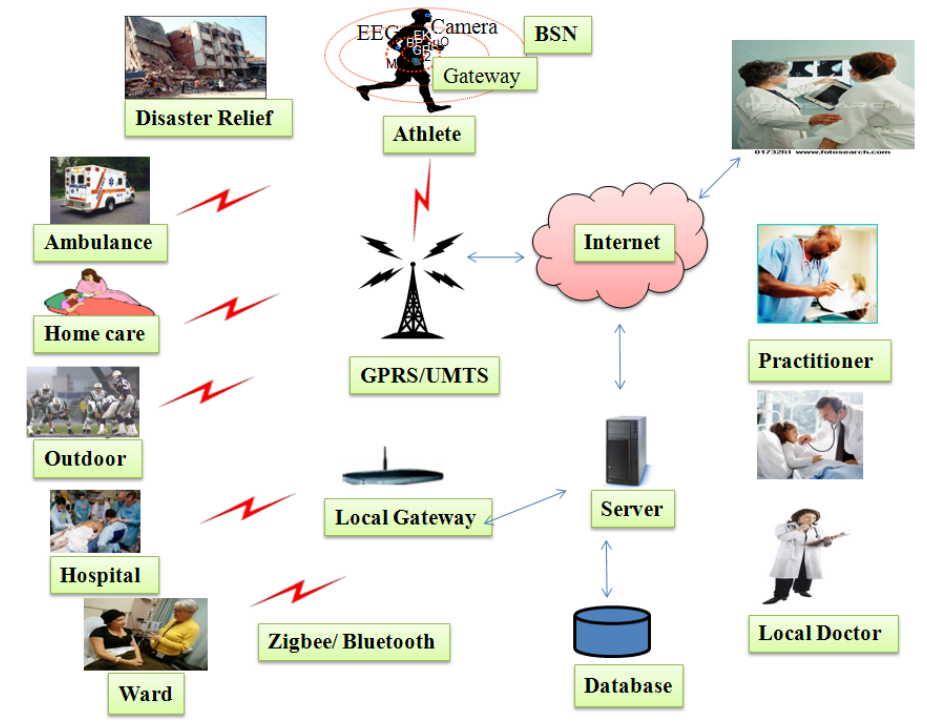
Figure 2. Healthcare application using wireless medical sensor